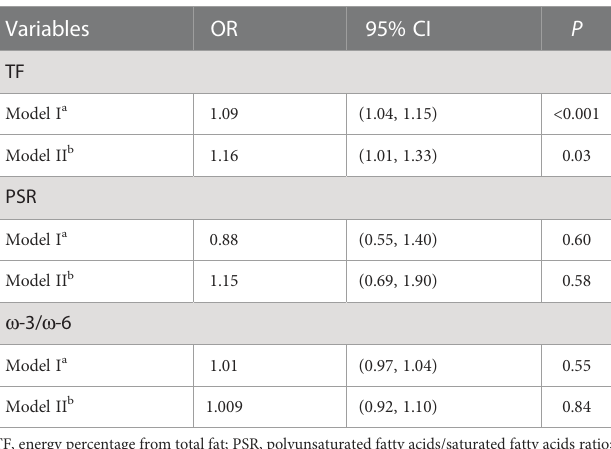
TABLE 3 Logistic regression of the association between dietary fat quality indices and breast cancer.